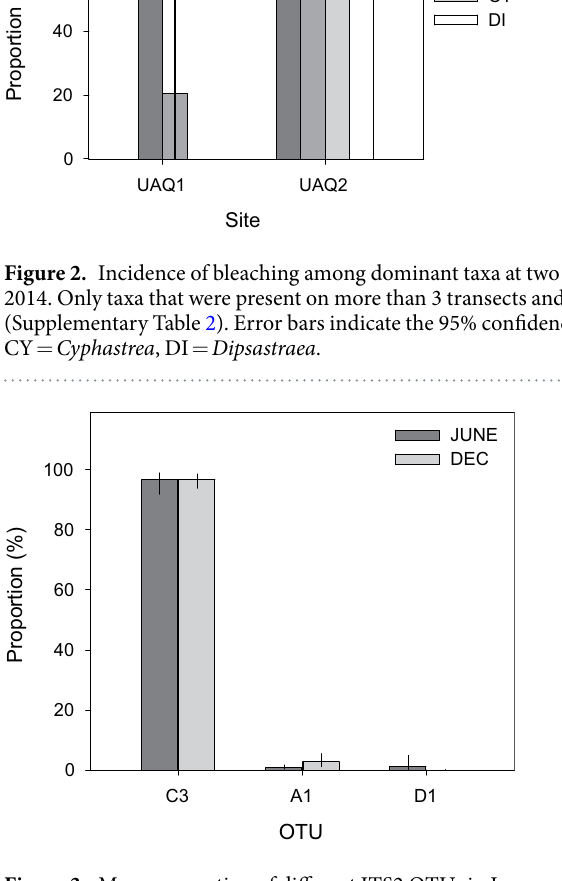
Figure 3. Mean proportion of different ITS2 OTUs in June and December 2014. Error bars show the 95% confidence